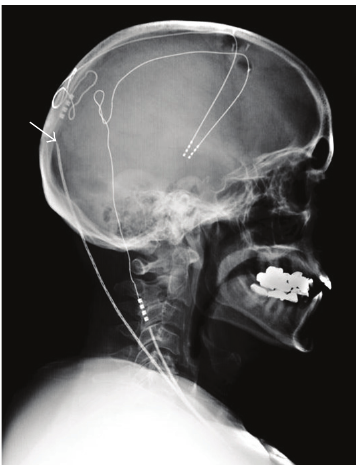
Figure 2: Lateral X-ray showing a new discontinuity of the right extension lead over the skull at the connection to the right DBS electrode. Note the braided appearance of the right extension lead.